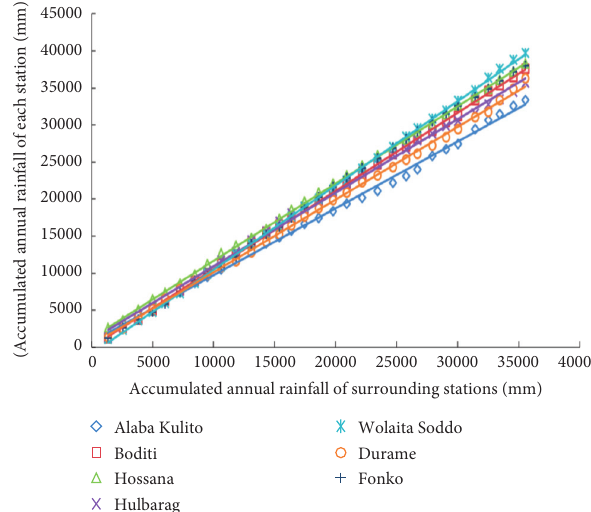
Figure 4: Consistency analysis using